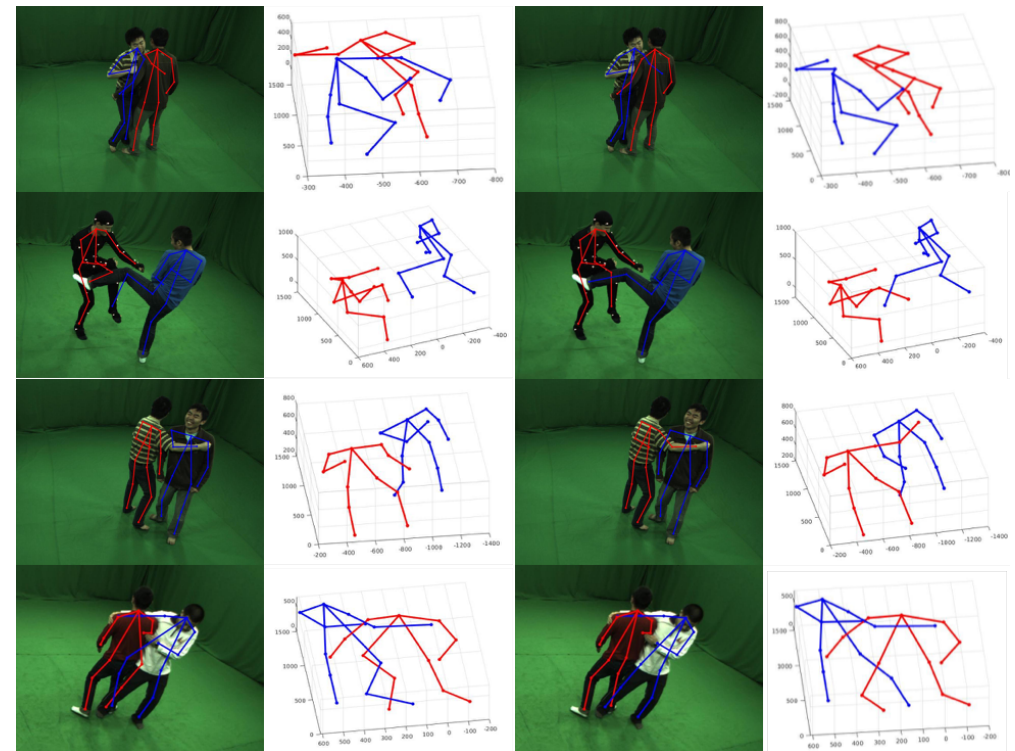
Figure 7. Comparison results with voting method. The first two columns are the pose detection results using voting method. Results of our method are shown in the last two